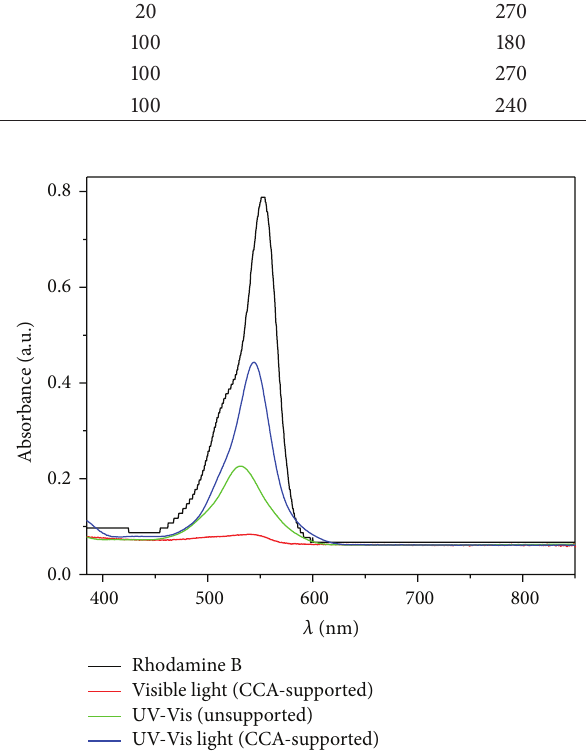
Figure 1: Graph showing absorbance of Rhodamine B before and after illumination with visible